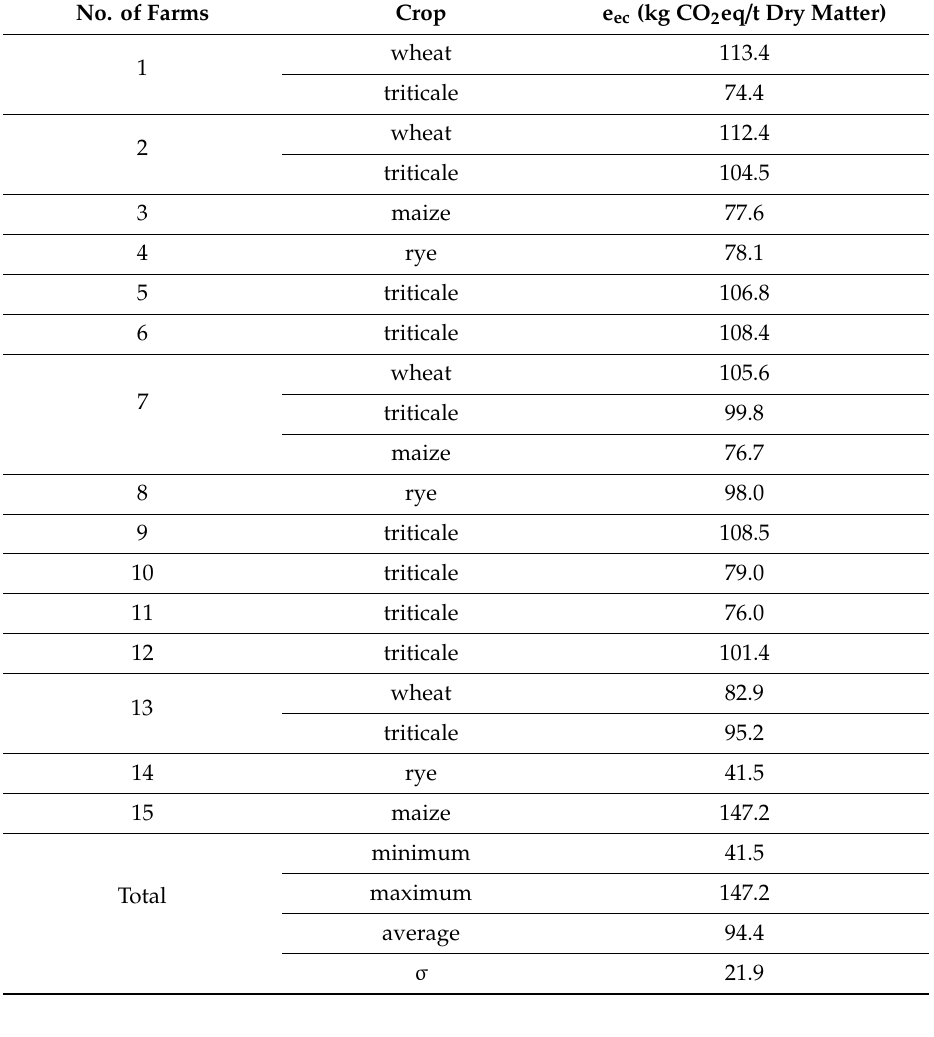
Table 3. GHG emissions from cultivation of agricultural crops for biofuels (e ec ).